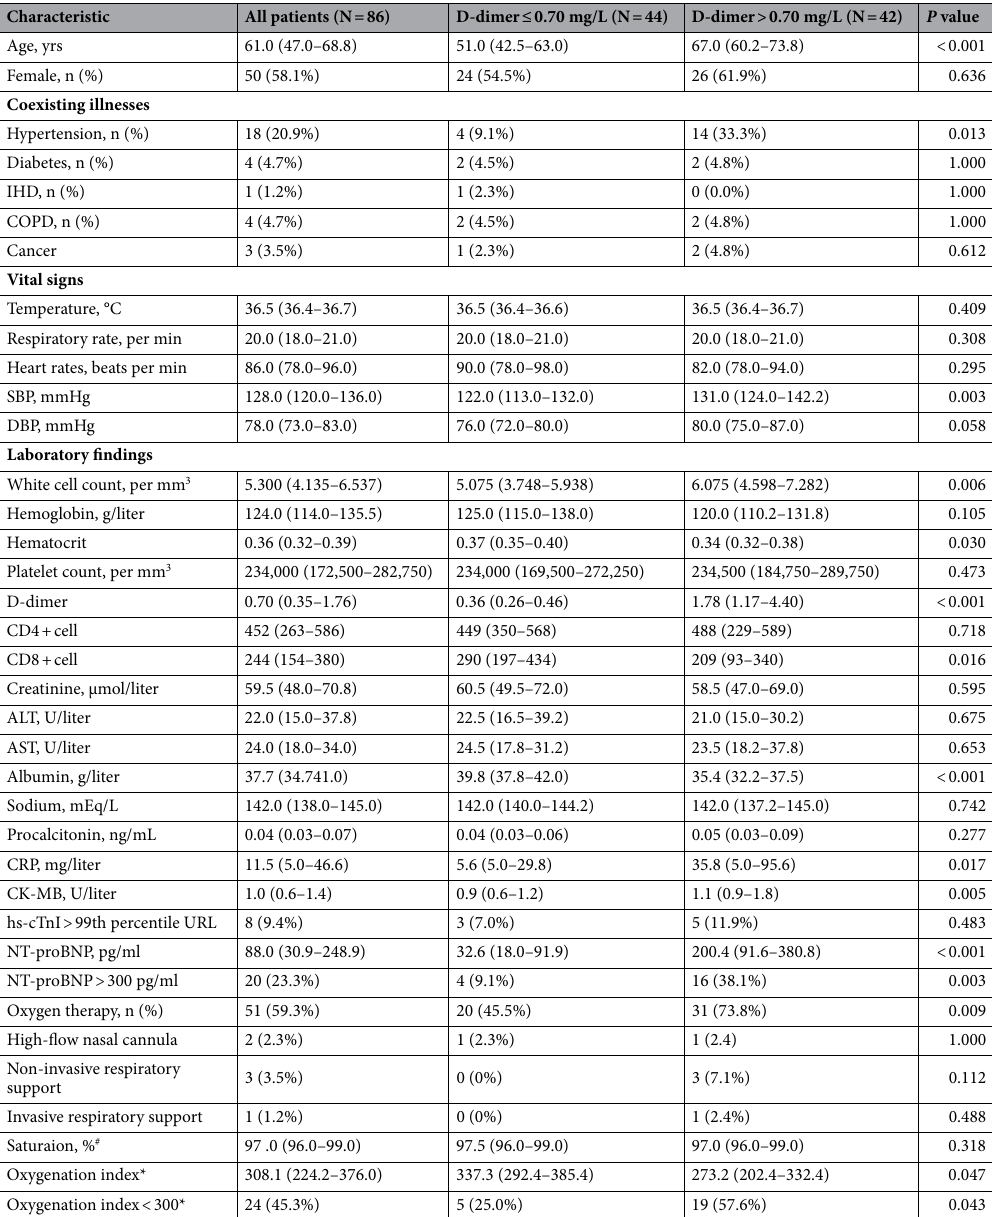
Table 1. Comparison of clinical characteristics between patients with D-dimer ≤ 0.7 mg/L and > 0.7 mg/L. Data are expressed as median (interquartile range) or counts and percentage, as appropriate. IHD Ischemic